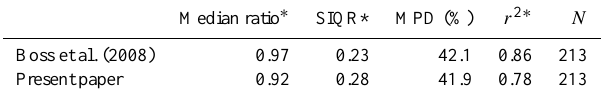
Table 5. Comparison, on a subset of DYFAMED data, of “satellite- corrected” and “Boss-calibrated” Chl a C with concomitant HPLC values. See the caption of Table 3 for details about